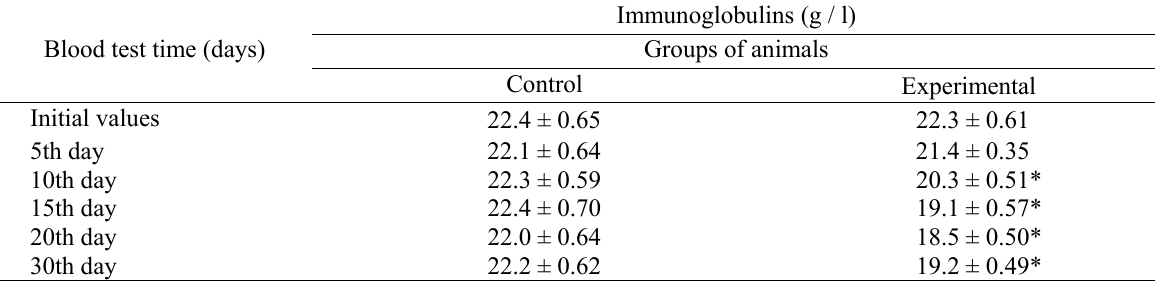
Blood test time